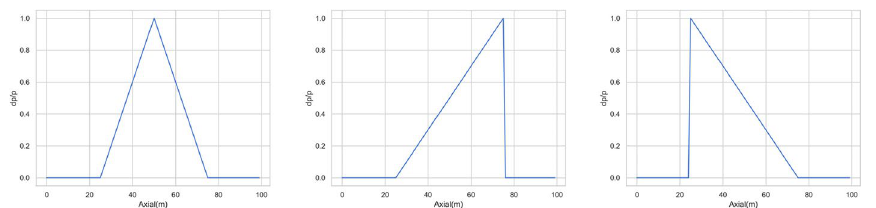
Fig. 5 A diagram of the triangular wave, right sawtooth wave, and left sawtooth wave